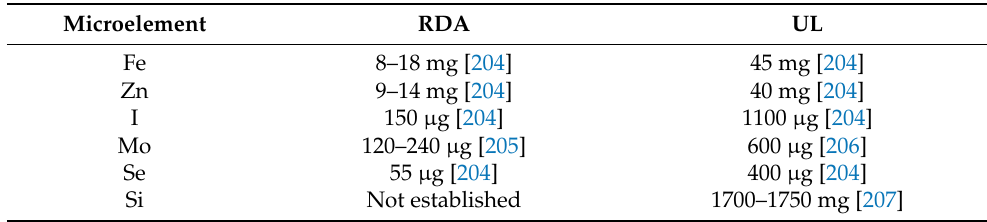
Table 3. Recommended daily allowances (RDA) and daily tolerable upper levels (UL) for iron (Fe), zinc (Zn), iodine (I), molybdenum (Mo), selenium (Se), and silicon